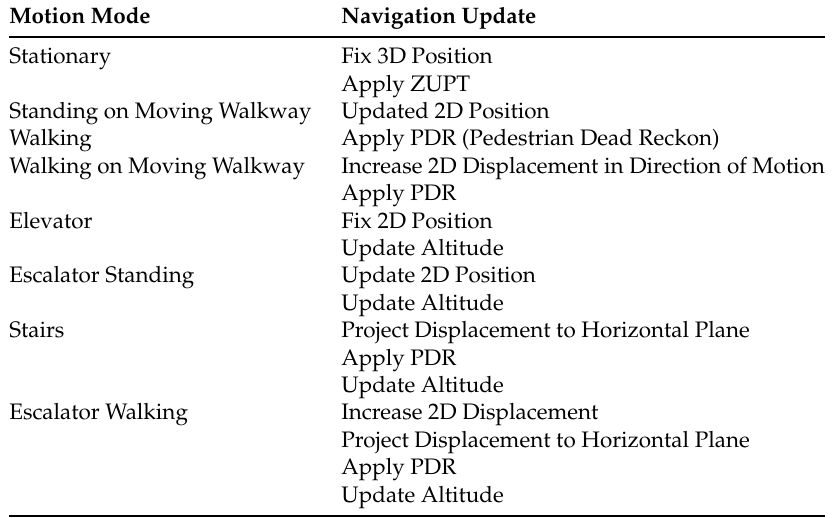
Table 4. Pedestrian navigation update strategies.